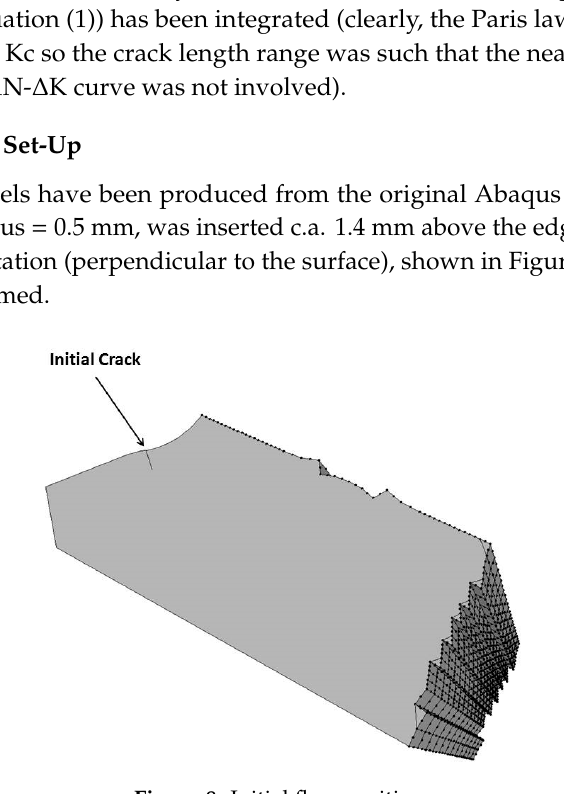
Figure 8. Initial flaw position.